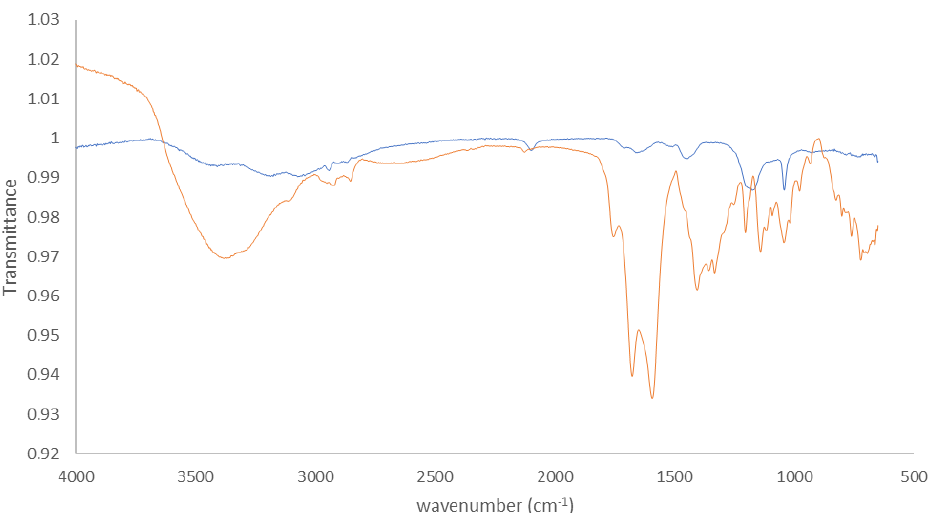
Figure A5. XPS spectra (C1s, S2p, N1s, O1s) of an Au plate electrode modified with Product 7. FTIR